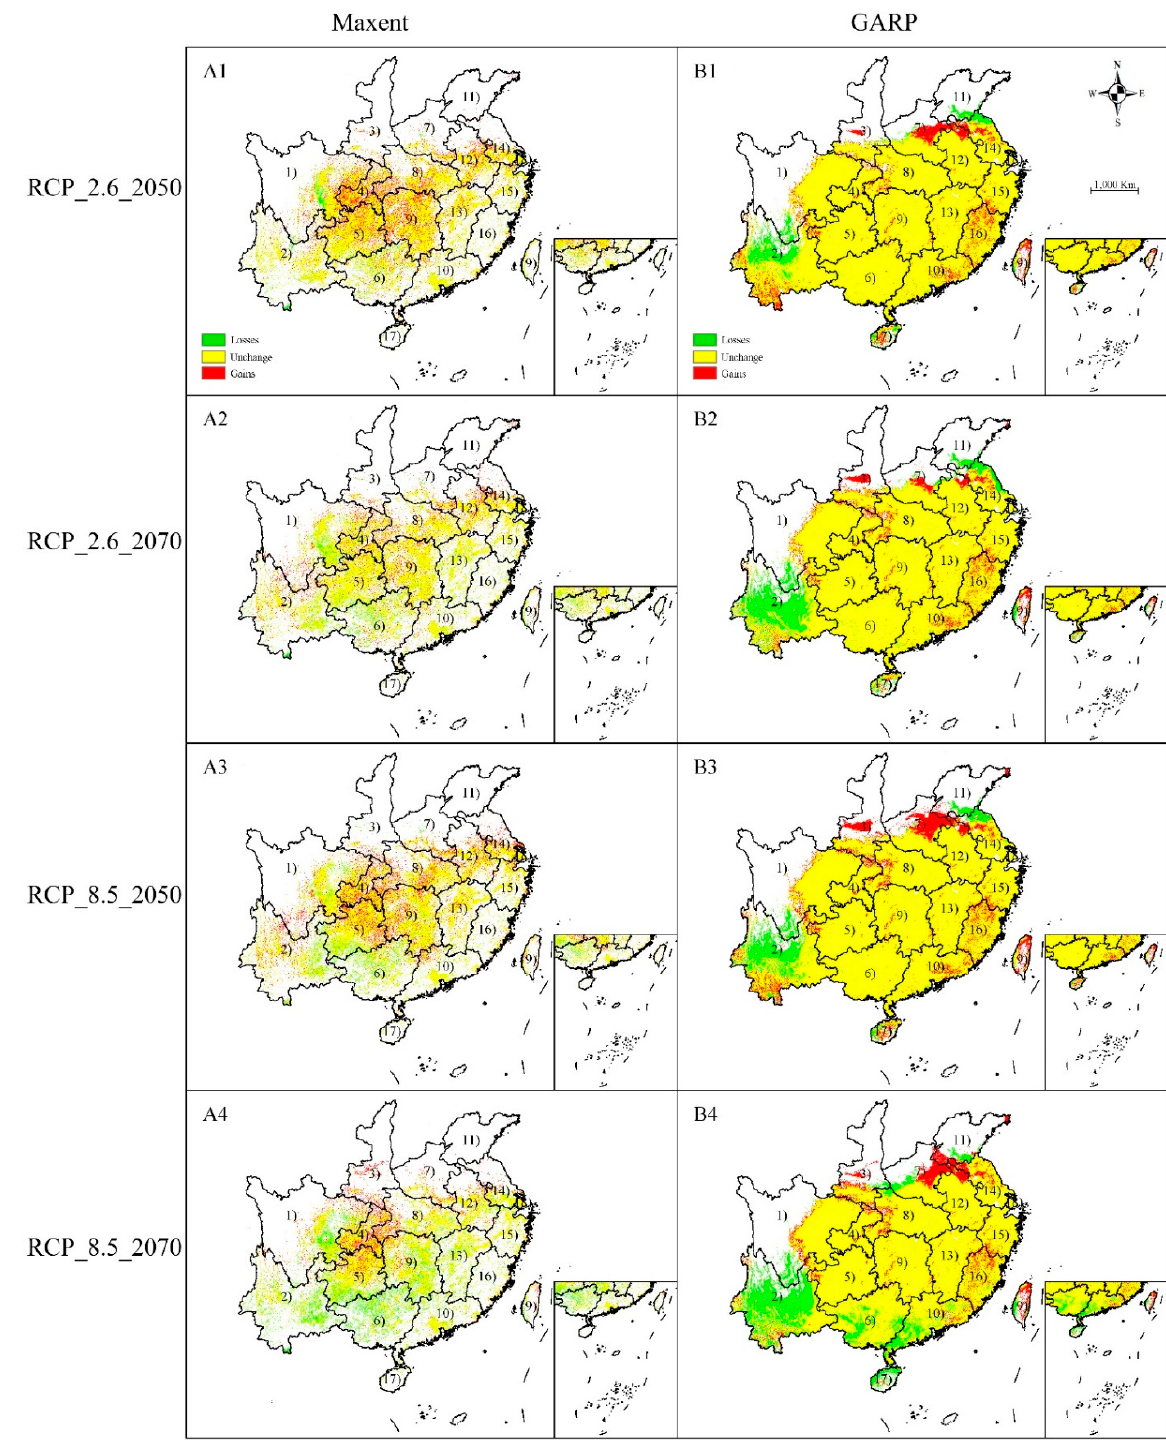
Figure 4. Comparison between current potential habitat and habitat under climate change scenarios RCP2.6 and RCP8.5 by Maxent ( A1 – A4 ) and GARP ( B1 – B4 ). A1, B1: scenarios for RCP 2.6–2050; A2, B2: scenarios for RCP 2.6–2070; A3, B3: scenarios for RCP 8.5–2050; A4, B4: scenarios for RCP 8.5–2070. White areas indicate unsuitable habitats; yellow, red, and green area indicate unchanged, increased, and decreased suitable habitat, respectively, compared with the current potentially suitable habitat. ( 1 ), Sichuan; ( 2 ), Yunnan; ( 3 ), Shanxi; ( 4 ), Chongqing; ( 5 ), Guizhou; ( 6 ), Guangxi; ( 7 ), Henan; ( 8 ), Hubei; ( 9 ), Hunan; ( 10 ), Guangdong; ( 11 ), Shandong; ( 12 ), Anhui; ( 13 ), Jiangxi; ( 14 ), Jiangsu; ( 15 ), Zhejiang; ( 16 ), Fujian; ( 17 ), Hainan; ( 18 ), Taiwan. Only the provinces where C. camphora was predicted to occur are shown.